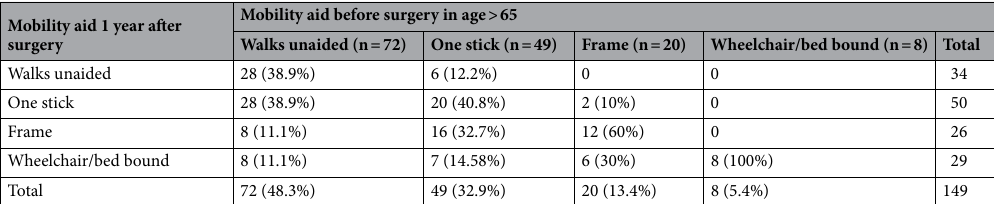
Table 5. Mobility changes of patients (age > 65 years old) before and 1-year after surgery.